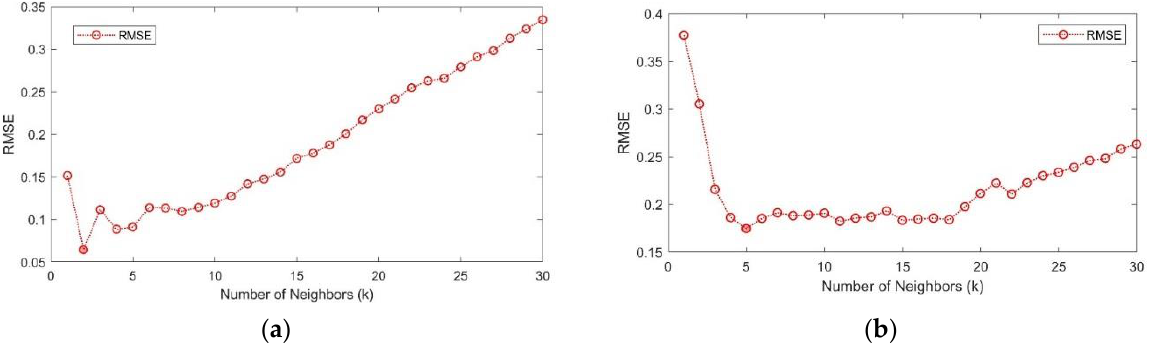
Figure 11. Obtained RMSE for the UCS and EM, respectively, by the KNN algorithm for different values of K, ( a ) for UCS and ( b ) for EM.